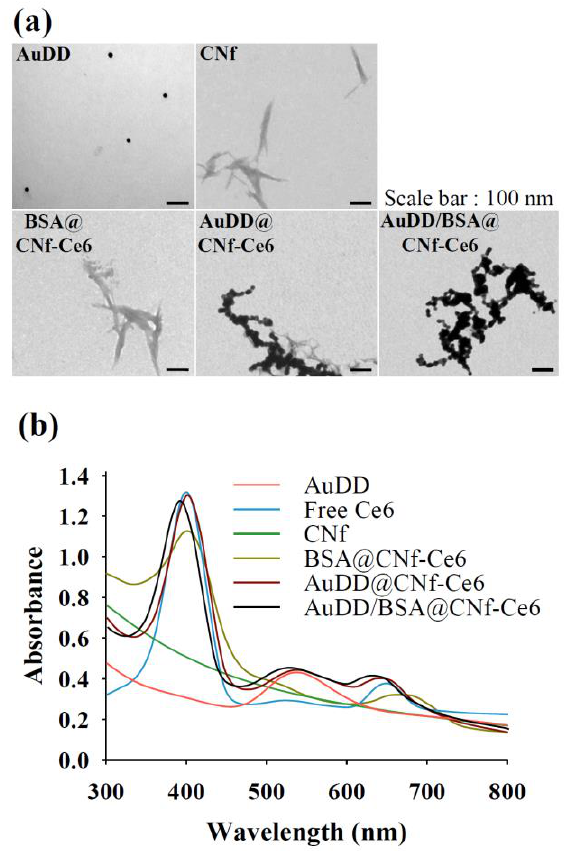
Figure 2. ( a ) TEM images of each nanostructure. ( b ) UV/Vis spectrum of all